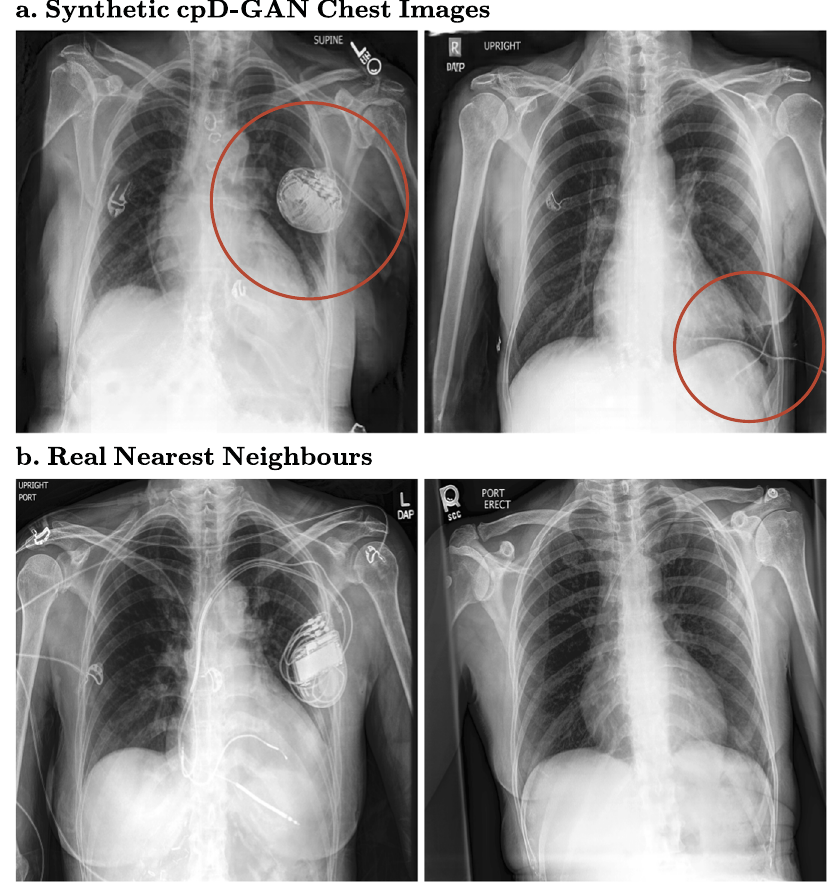
Fig. 5 Synthetic images with visual artefacts. a Synthetic images with visual artefacts, generated by the cpD-GAN, and b real nearest- neighbour images from the training dataset at 512 × 512 pixels. The red circles surround unrealistic image neighbourhoods: Artefacts resulting from the support devices